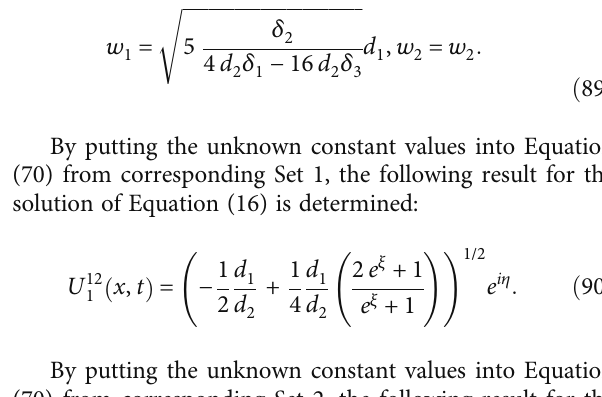
ð x , t Þj for NLFD of order α and for parameters δ 1